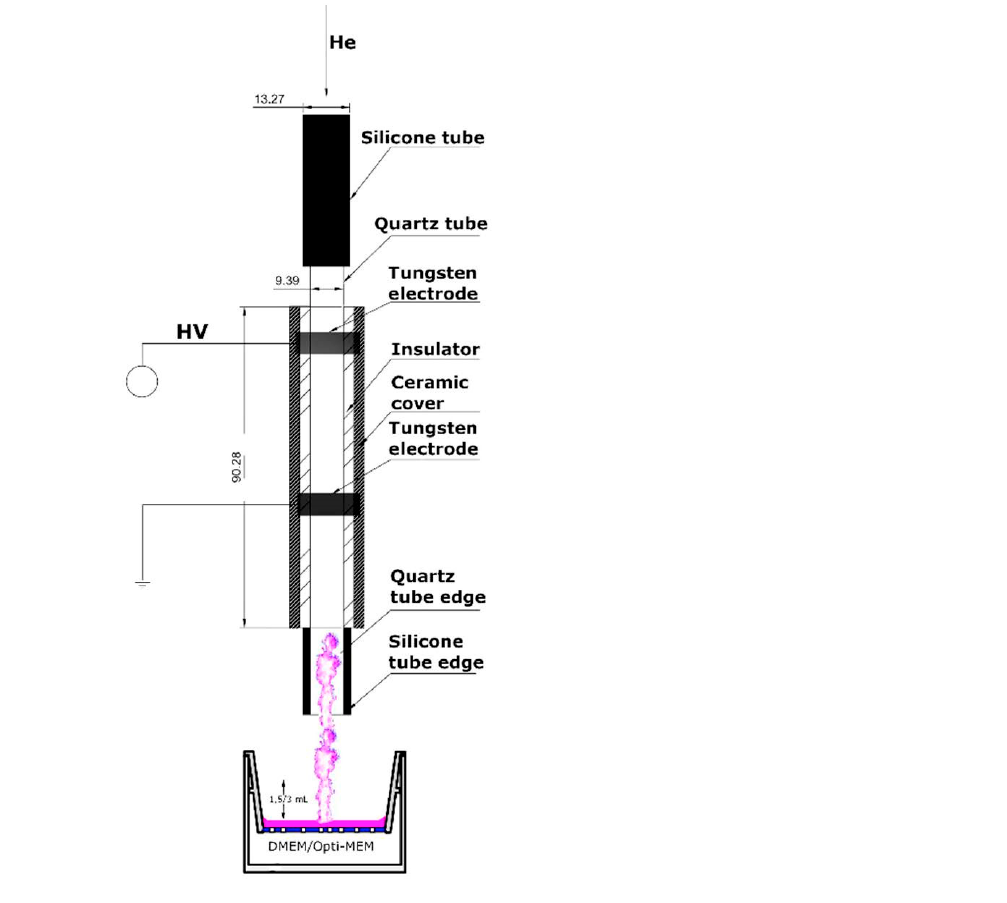
Figure 8. The CAPP-based reaction-discharge system used for the CAPP-activated media production.